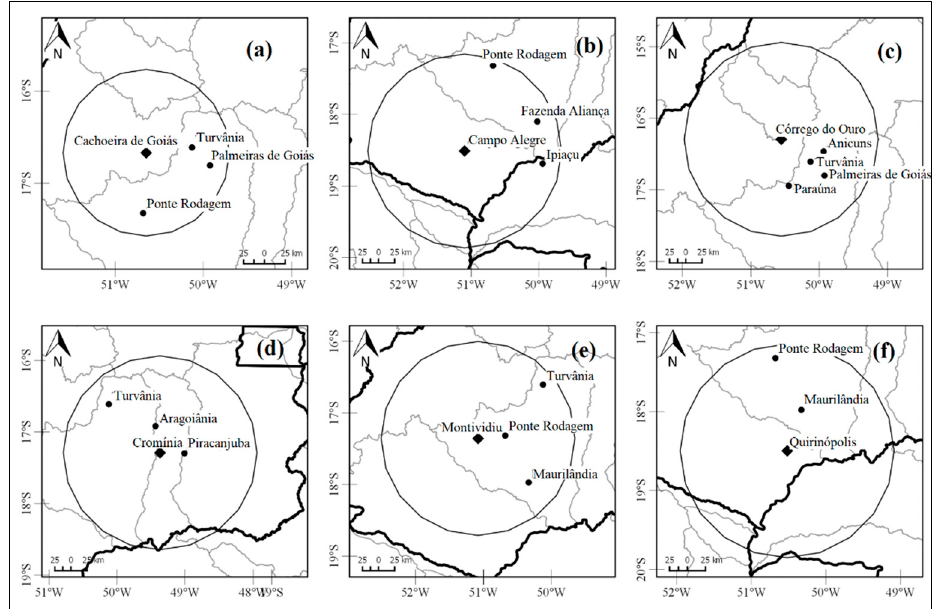
Figure 2. Locations of the target sites and their respective” donor” stations for filling daily rainfall values with the multiple linear regression models: ( a ) Cachoeira de Goiás 100, ( b ) Campo Alegre 150,